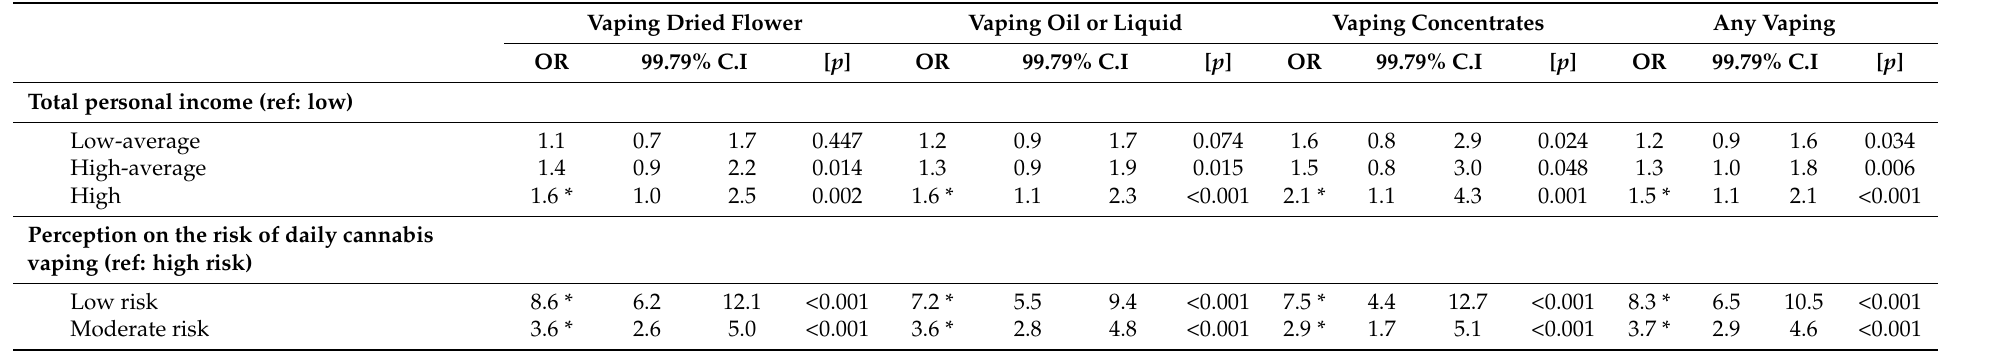
Table A2. Cont. Vaping Dried Flower Vaping Oil or Liquid Vaping Concentrates Any Vaping